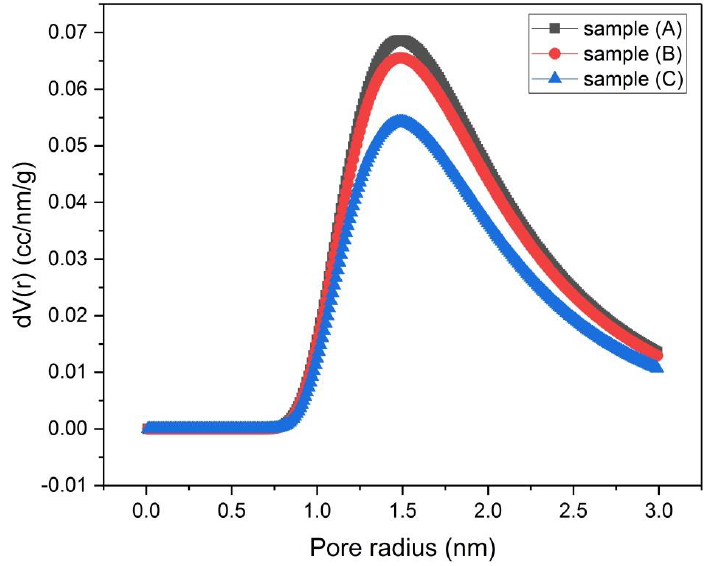
Figure 8. Micropore size distribution by the Dubinin–Astakhov (DA) method for samples (A), (B) and (C).